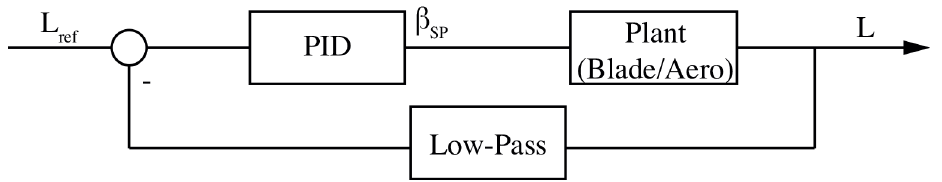
Figure 10. Feedback PID controller based on lift measurements of the force balance. Reference lift is based on a 10s mean at constant inflow conditions. β SP denotes the set point of the flap. The system plant comprises the flap mechanics and the aerodynamics.